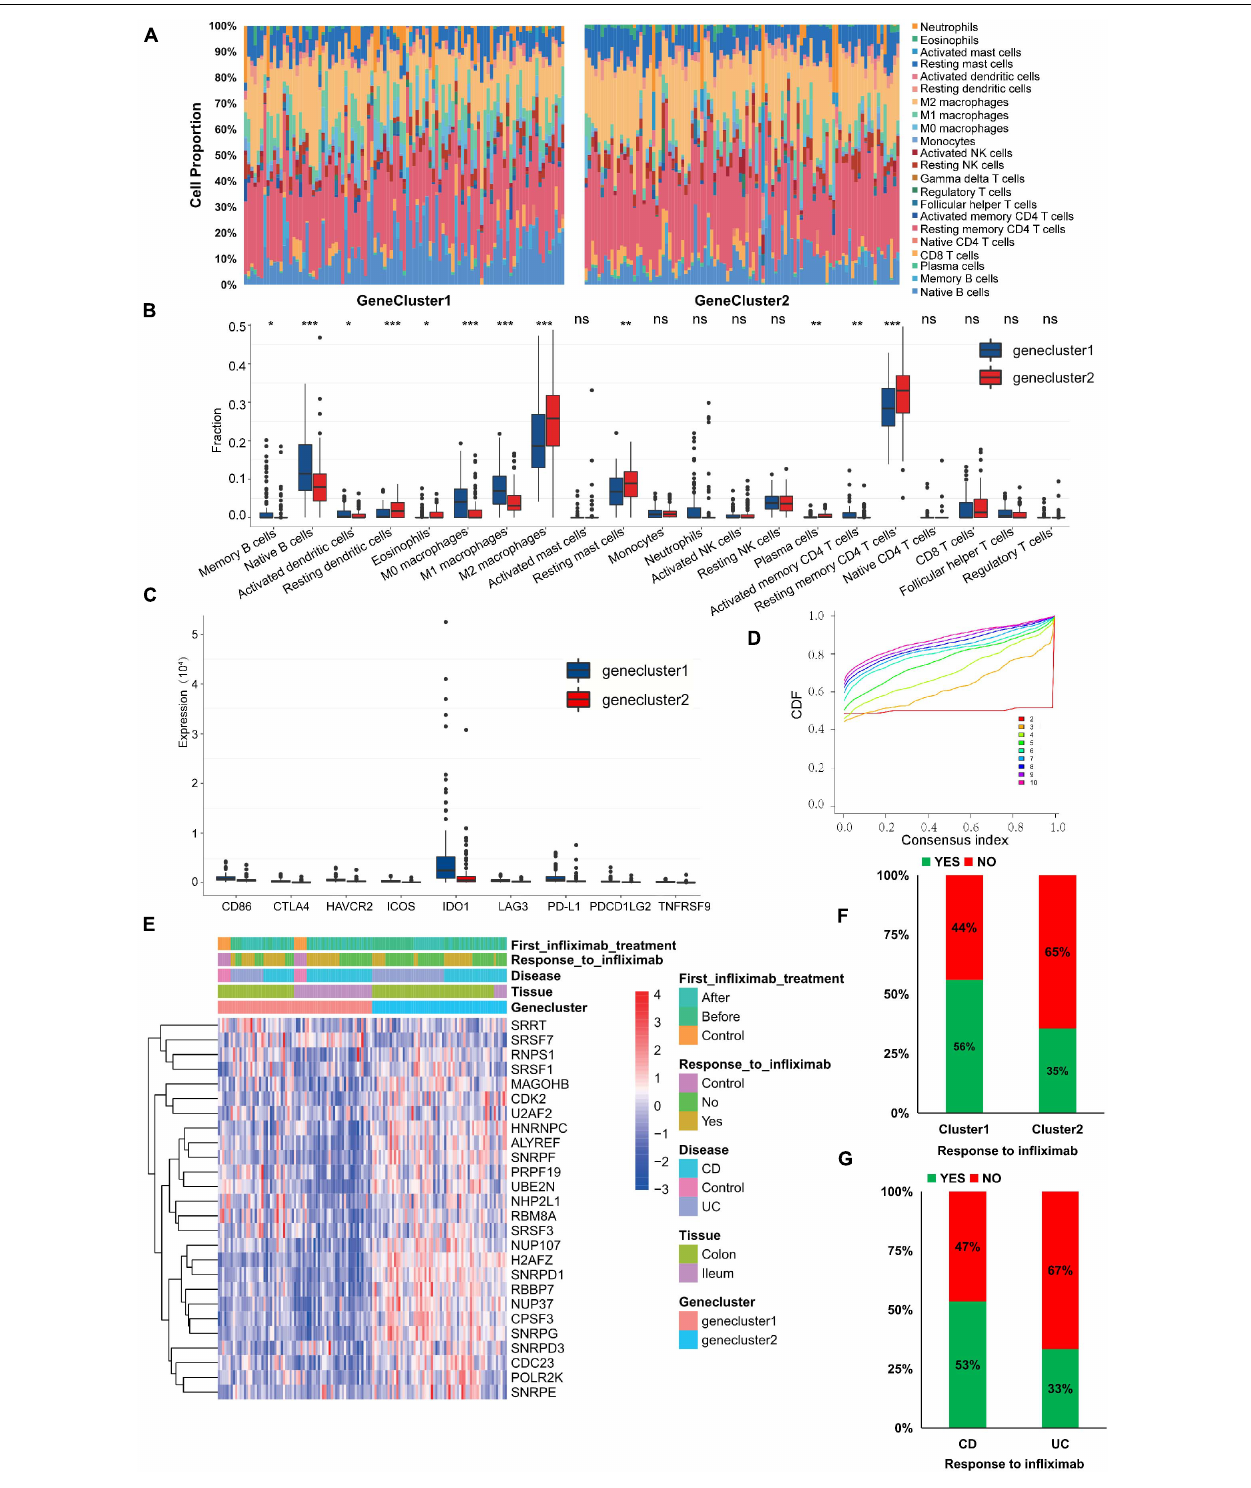
FIGURE 6 | m 6 A phenotype–related hub genes influence the immune infiltration and therapeutic response. (A,B) The immune cell infiltrating levels in different gene cluster subtypes in the GSE111889 cohort. (C) The expression differences of nine important immune checkpoints among different gene clusters. (D) Consensus clustering cumulative distribution function (CDF) for k = 2–10. (E) The expression of hub genes, anti-TNF therapeutic response, and disease subtype between genecluster1 and genecluster2. (F,G) Infliximab therapeutic response in different gene clusters (F) and disease subtypes (G) . The asterisks represented the statistical P -value (* P < 0.05; ** P < 0.01; *** P < 0.001).